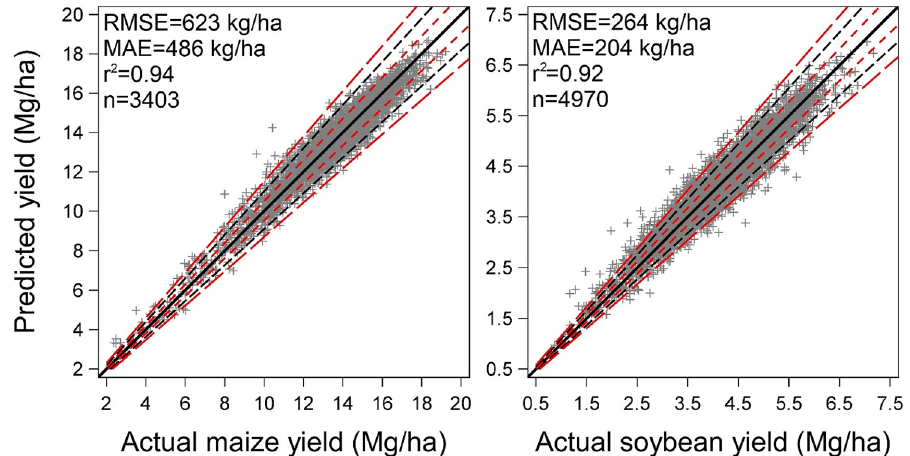
Figure 2. Actual versus algorithm-derived maize (left) and soybean (right) yield in test datasets. Black solid line indicates y = x, red short-dashed lines, black dashed lines, and red long-dashed lines indicate ± 5, 10, and 15% deviation from the y = x line. RMSE, root mean square error; MAE, mean absolute error; r 2 , coefficient of determination; n = number of observations. Each observation corresponds to a yield of an individual cropping system in a specific environment (location-year).